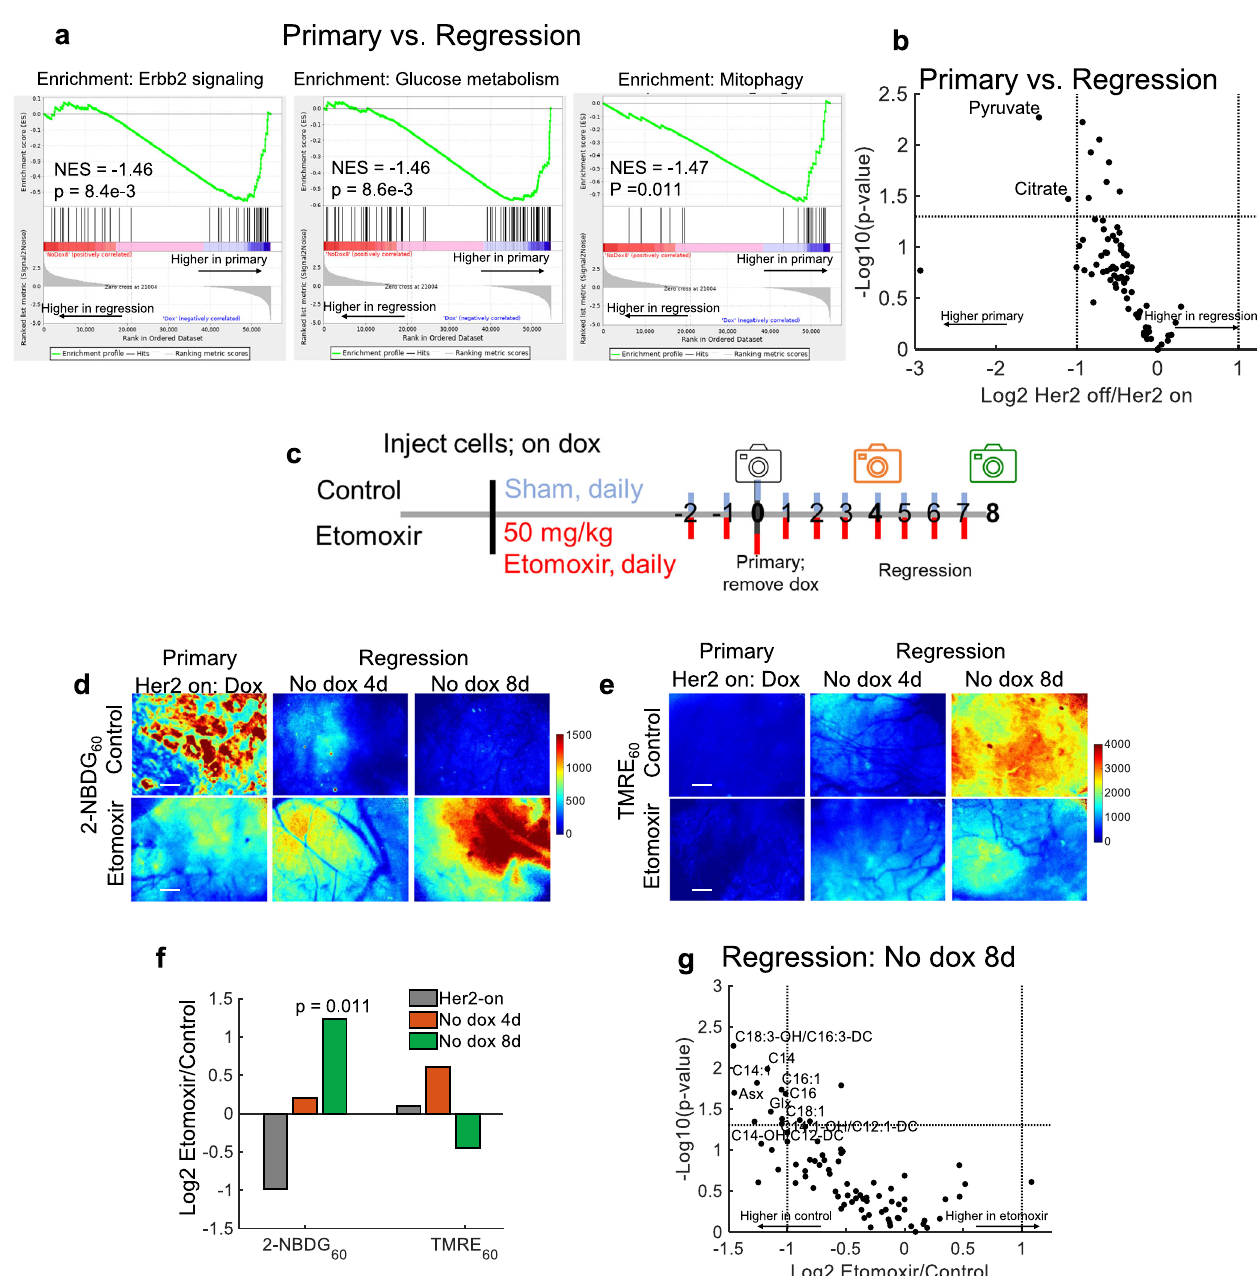
Fig. 4 Treatment with a fatty acid oxidation inhibitor supports a shift from glucose to fatty acids as a fuel source in fast-recurring tumors. a Gene set enrichment analysis (GSEA) of primary (dox) and regressing (no dox 8 days) tumors. Enrichment scores were calculated using the KS statistic and p -values were calculated using permutation testing with 1000 permutations. b Volcano plot of fold-change in metabolite levels in regressing relative to primary tumors. Dashed lines represent p < 0.05 via two-sided t -test and |Log2FoldChange| > 1. Signi fi cantly different metabolites are labeled within the graph ( n = 5 per group). c Schematic of treatment and imaging (camera icon) time points of control and Etomoxir treated mammary window chambers. d Representative 2-NBDG 60 images of primary, Her2 on ( + dox) and regressing (No dox 4 and 8 days) tumors (both untreated (Control) and treated with Etomoxir). e Representative TMRE 60 images of primary, Her2 on ( + dox) and regressing (No dox 4d and 8d) tumors (both untreated (Control) and treated with Etomoxir). Scale bar = 200 µm. f Log2 fold-change in mean 2-NBDG 60 and TMRE 60 in primary (Her2-on) and regressing (No dox 4d and 8d) tumors treated with Etomoxir compared with untreated tumors (control). (Log2 fold-change = Log2 (Mean ETOMOXIR / Mean CONTROL )). Statistical comparisons of fold-changes were performed with a two-sided t -test between treated and control groups at each time point. (Control primary and regression tumor mice, n = 10; Etomoxir treated primary and regression tumor mice, n = 5). g Volcano plot of fold-change in metabolite levels between regressing tumors (no dox 8 days) with and without Etomoxir. Dashed lines represent p < 0.05 via two-sided t -test and |Log2FoldChange| > 1. Signi fi cantly different metabolites are labeled within the graph. n = 5 per